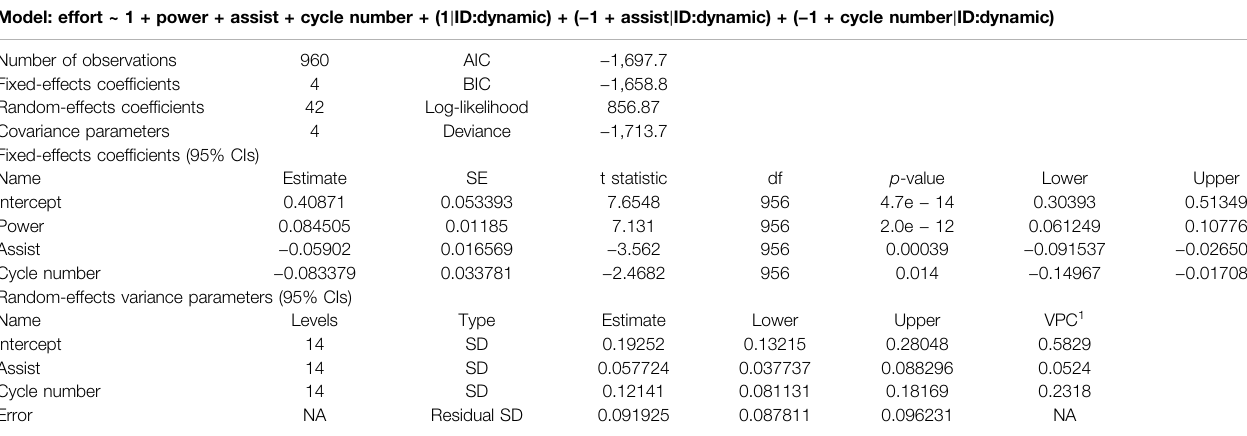
TABLE 2 | Mixed-effects model for user effort.